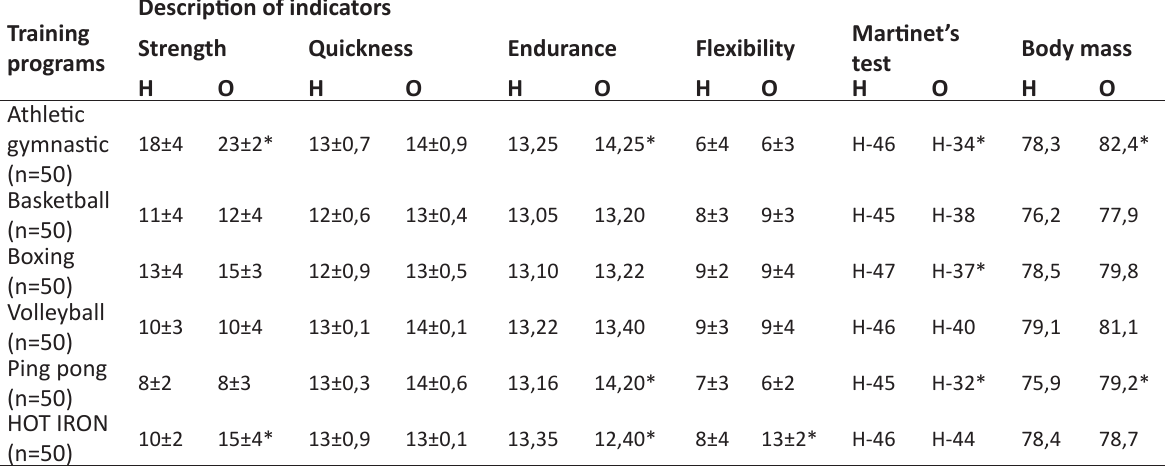
Table 1. Indicators of physical condition and functional fitness of the tested students (boys– n=300) Training